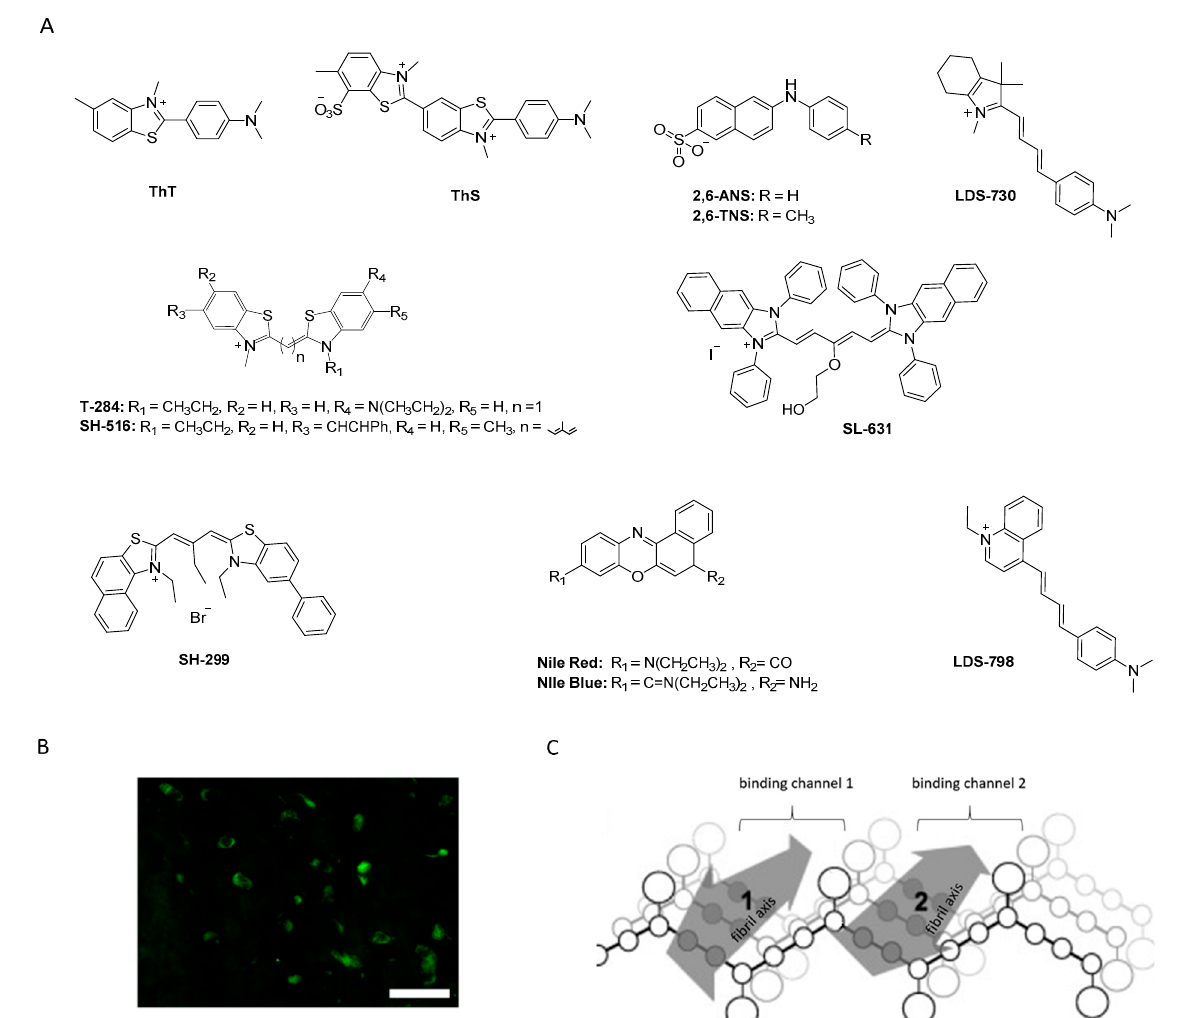
Figure 5. ( A ) Chemical structures of fluorescent probes and cyanine dyes. ( B ) ThS positive neurons confirming α -syn pathology (adapted from Patterson et al.) [88]. ( C ) Hypothetical presentation of how mono- and trimethine cyanine dyes interact with α -syn fibrils (reprinted with permission from [83]. Copyright 2008 Elsevier).